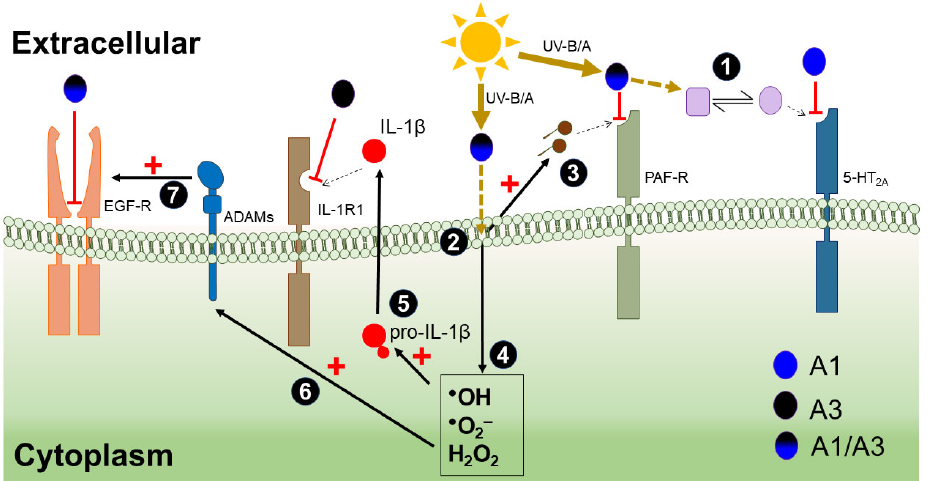
Figure 13. Proposed concomitant effects on UV ‐ induced damage signaling by A1 and A3 . The main UV ‐ induced molecular events are summarized in seven steps, indicated by numbered black spheres: